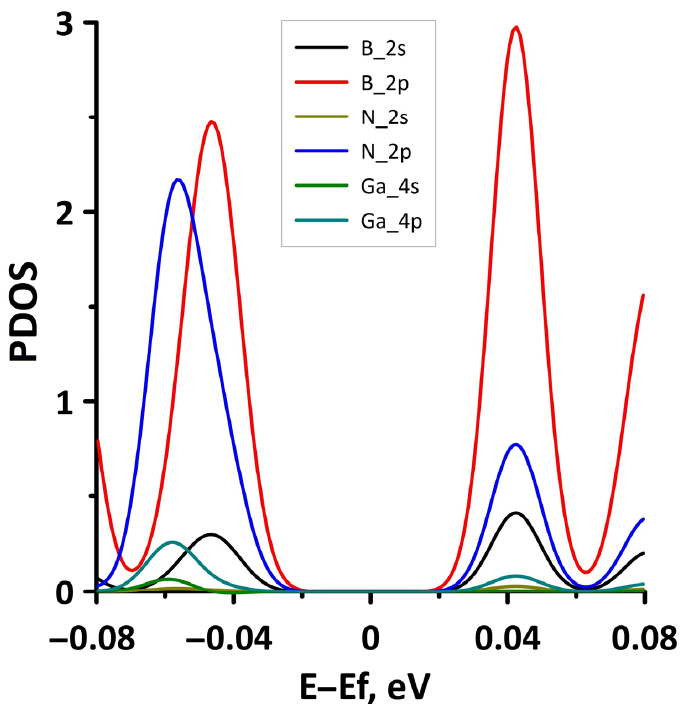
Figure 19. Fragments of PDOS near the Fermi level (shifted to 0 eV) of borophene/GaN heterostruc- ture under biaxial compression by 4%.